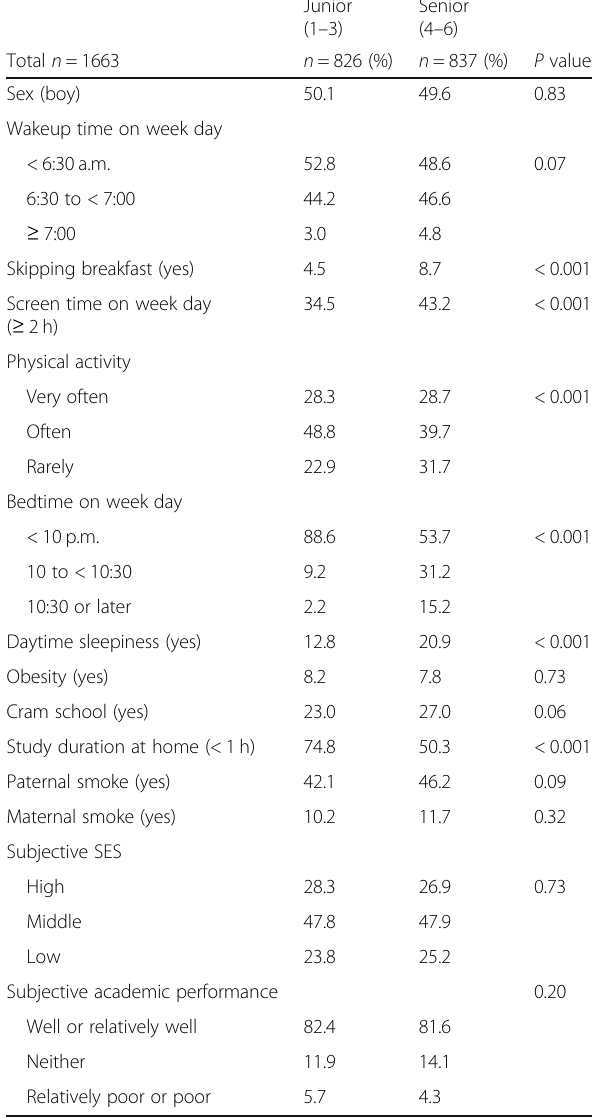
Table 1 Characteristics of participants by grade